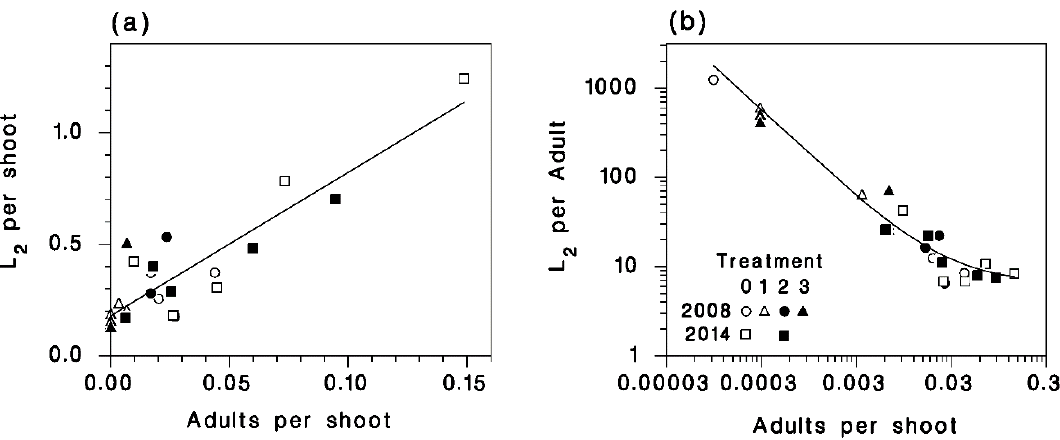
Table 5. General linear model (Equation (5)) of the effects of emerging adult density ( A ), Year ( Y ) and pheromone treatment ( T ) on L 2 density. Reduced model.